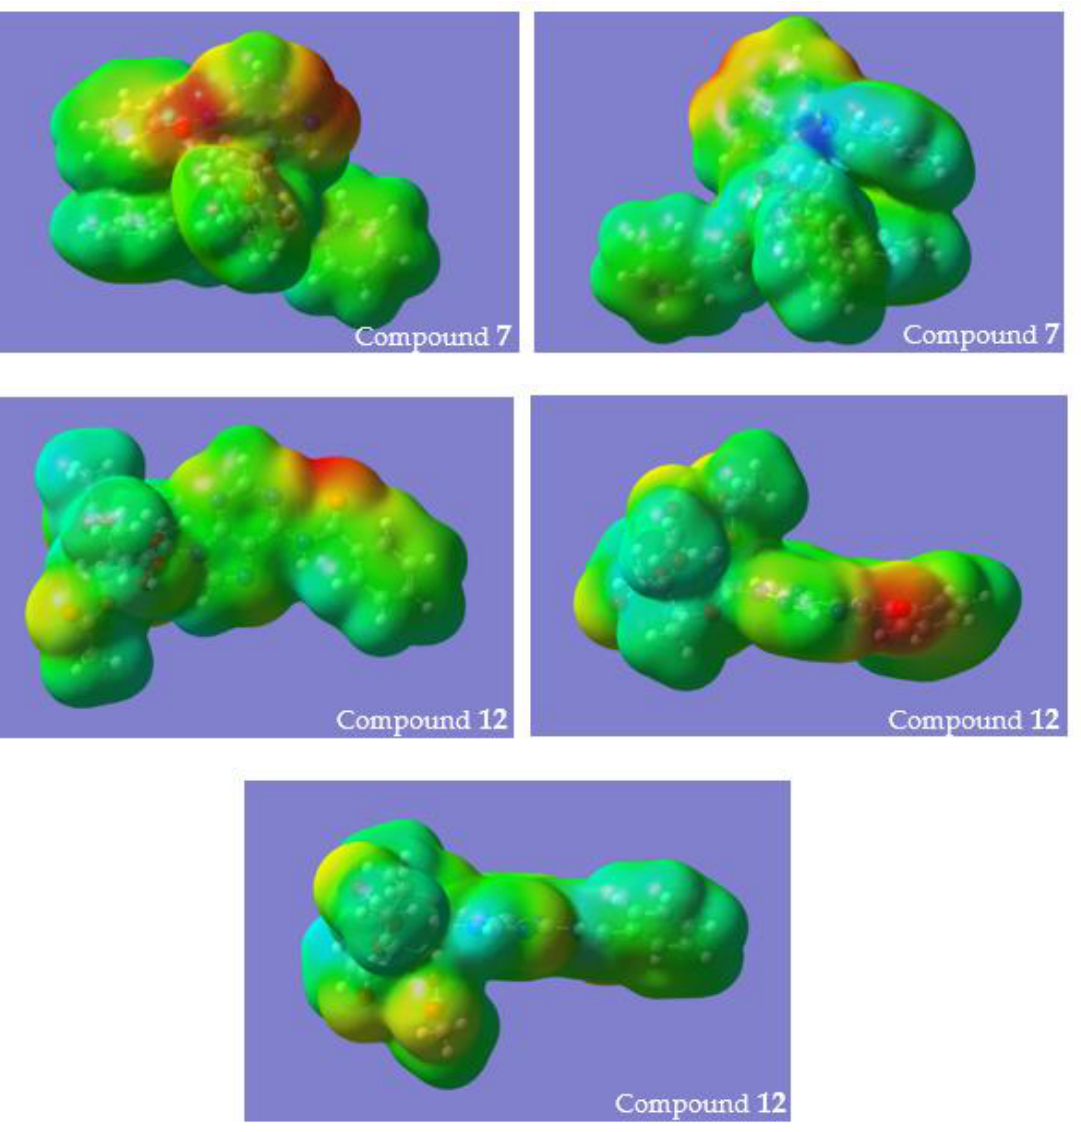
Figure 4. Different views of the molecular electrostatic potential surfaces for compounds 7 and 12, deduced by Gaussian16 with CAM-B3LYP/def2TZVP with IEFPCM for water. Based on the molecular electrostatic potential map generated for compound 12 , the geometry for the complex compound 12 -Cu 2+ was optimized, starting with the copper ion placed near the amide group of the purine. The electronic transitions in water for the two possible conformers, “b” and “c,” of compound 12 in the absence and in the presence of Cu 2+ ions are presented in Figure 5. In comparison with the experimental results, the cal- culated transitions are displaced to shorter wavelengths; however, the bathochromic shift observed experimentally with the addition of Cu 2+ is also noticed in the calculated results. The larger red shift in λ max from 254 to 284 nm is observed for conformer “b.” Also, the energy difference between both complexes listed in Table 4 shows that complex 12 a-Cu 2+ is more stable. Finally, the optimized molecular geometry of complexes 12 -Cu 2+ is shown in Figure 6, and the electrostatic potential map for the most stable complex, the 12 a-Cu 2+ complex, is presented in Figure 7.